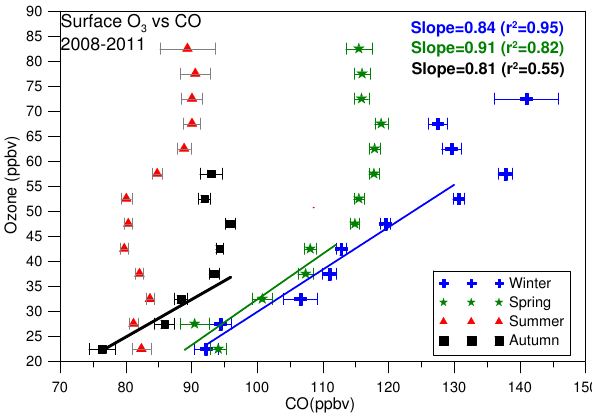
Fig. 12. CO (ppbv) vs. surface O 3 (ppbv) at IZO for winter (JFM), spring (AMJ), summer (JAS) and autumn (OND) in the period 2008–2011. Data have been grouped and depicted as for Fig. 8. Table 4. Averaged O 3 /CO ratios (ppbvppbv − 1 ) at IZO for winter, spring, summer and autumn (all cases and those with O 3 > P75th), and estimated type of air mass (FP=Fresh Pollution; A=Aged air mass; UT=Upper Troposphere). Types of air masses have been la- belled according to the O 3 /CO range values.